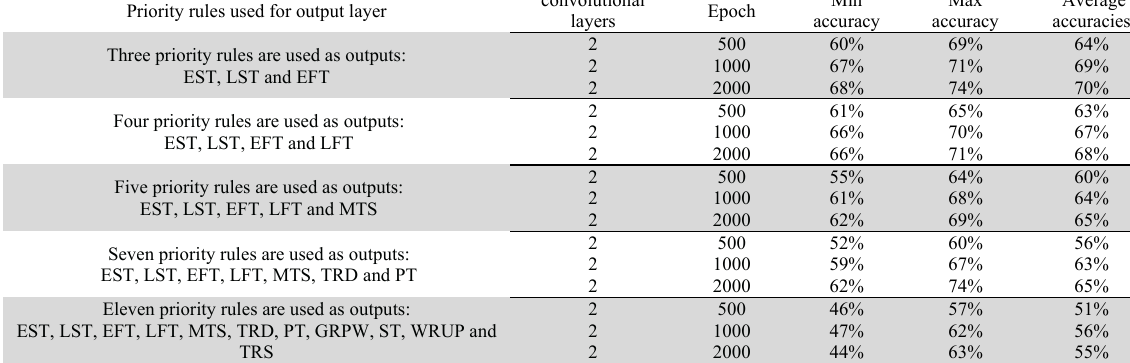
Training performance of developed convolutional neural network (CNN) with two convolutional layers Priority rules used for output layer